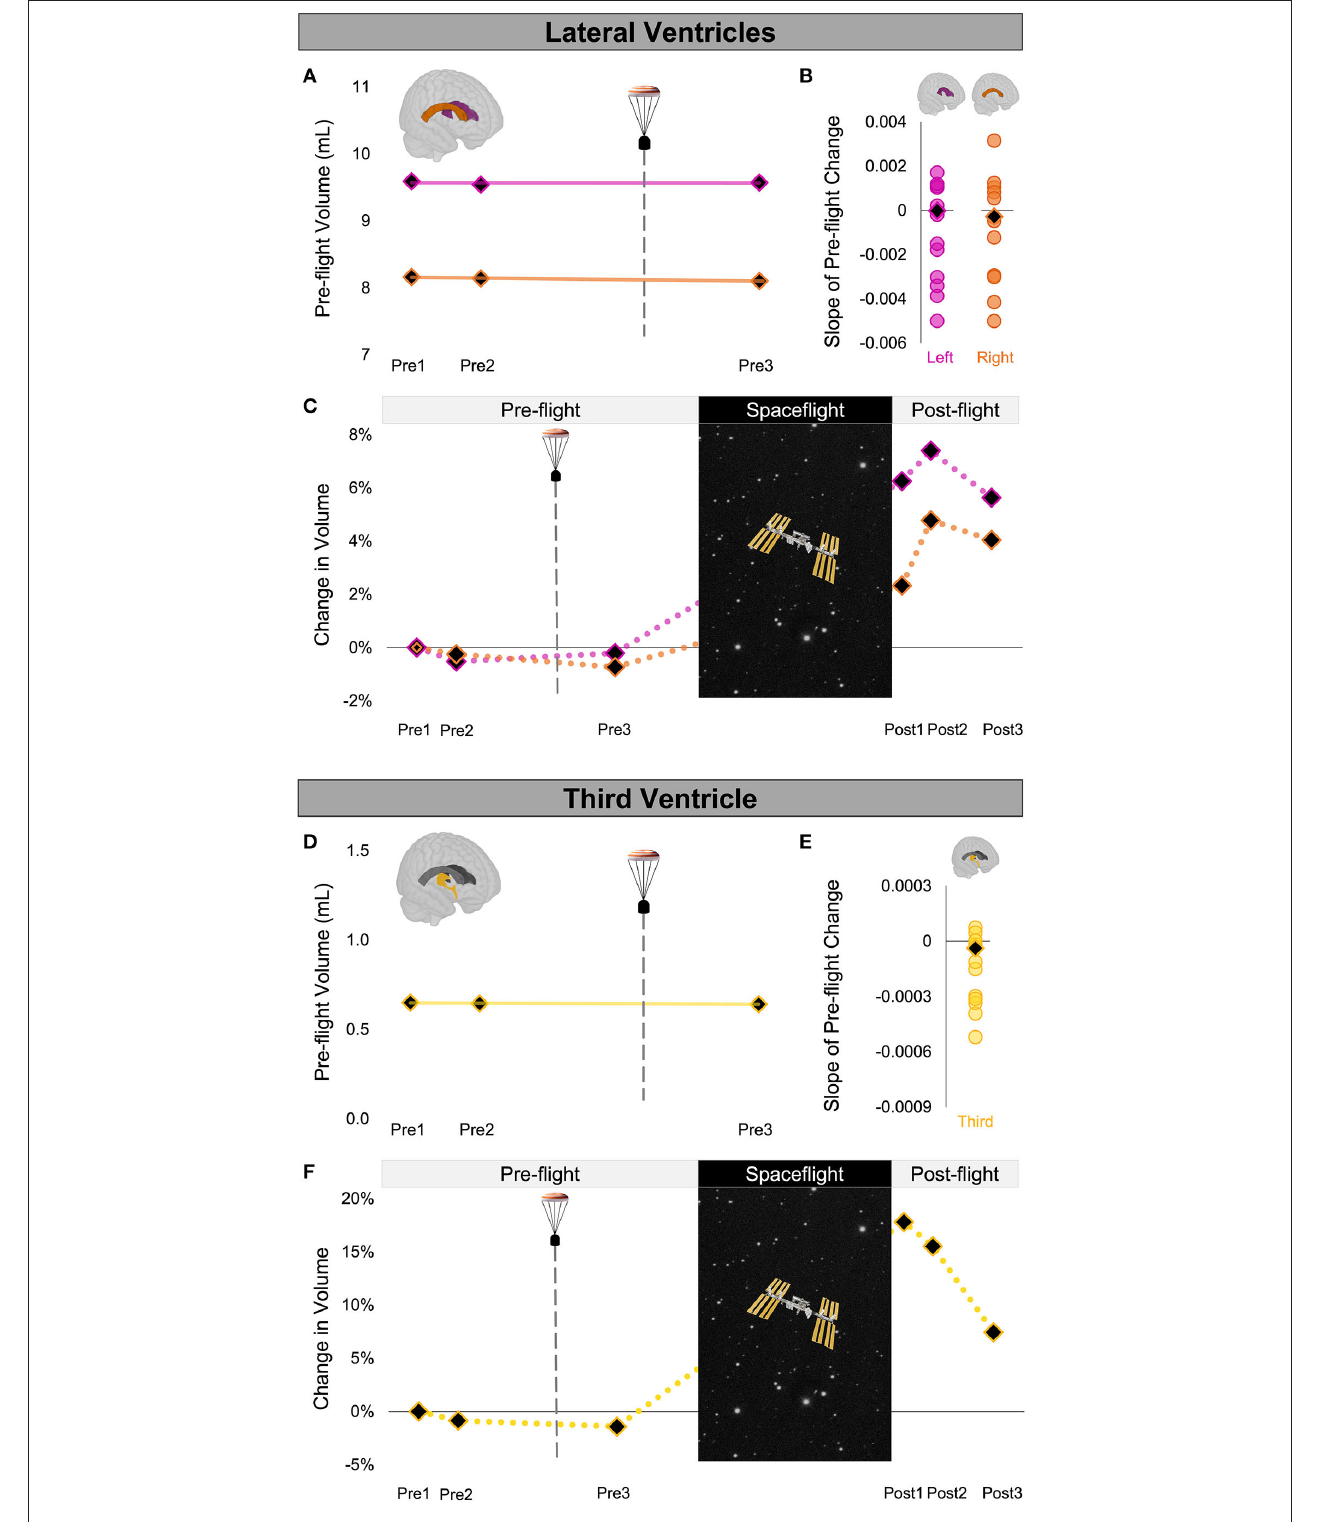
FIGURE 2 | Ventricle Volume Changes Following Launch Abort and Spaceflight. (A) CAL’s pre-flight volume changes for the left (magenta) and right (orange) lateral ventricles. The solid trend lines indicate the slopes of pre-flight ventricular volume changes. The aborted launch is indicated by the gray dashed line and capsule icon.